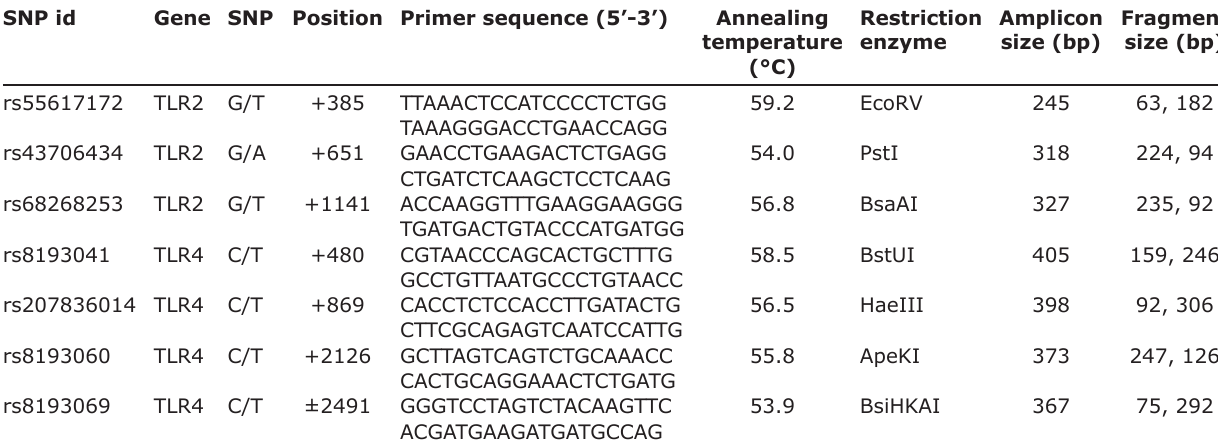
Table-1: SNPs with their primers and restriction enzymes. SNP id Gene SNP Position Primer sequence (5’-3’)